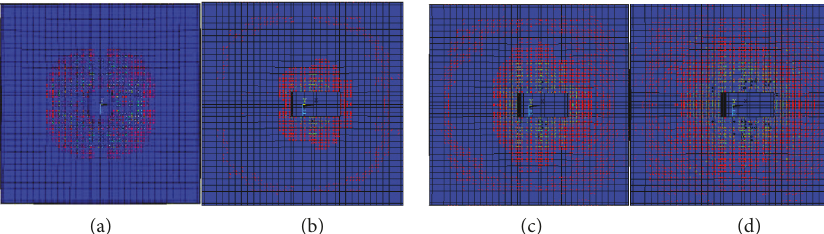
Figure 4: Crack propagation before failure from the finite element model. (a) e / t